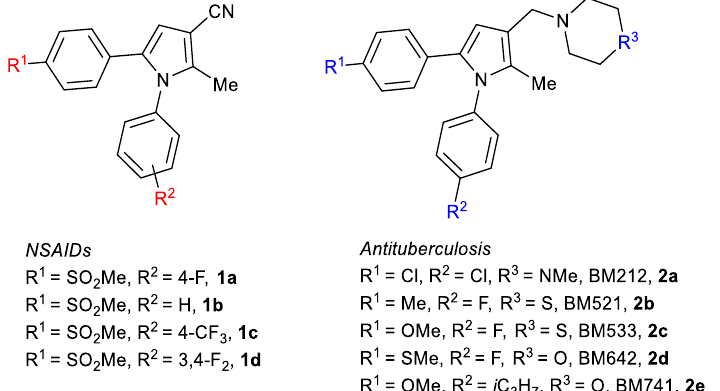
Figure 1. Examples of pyrrole-based drug lead compounds and drug candidates.